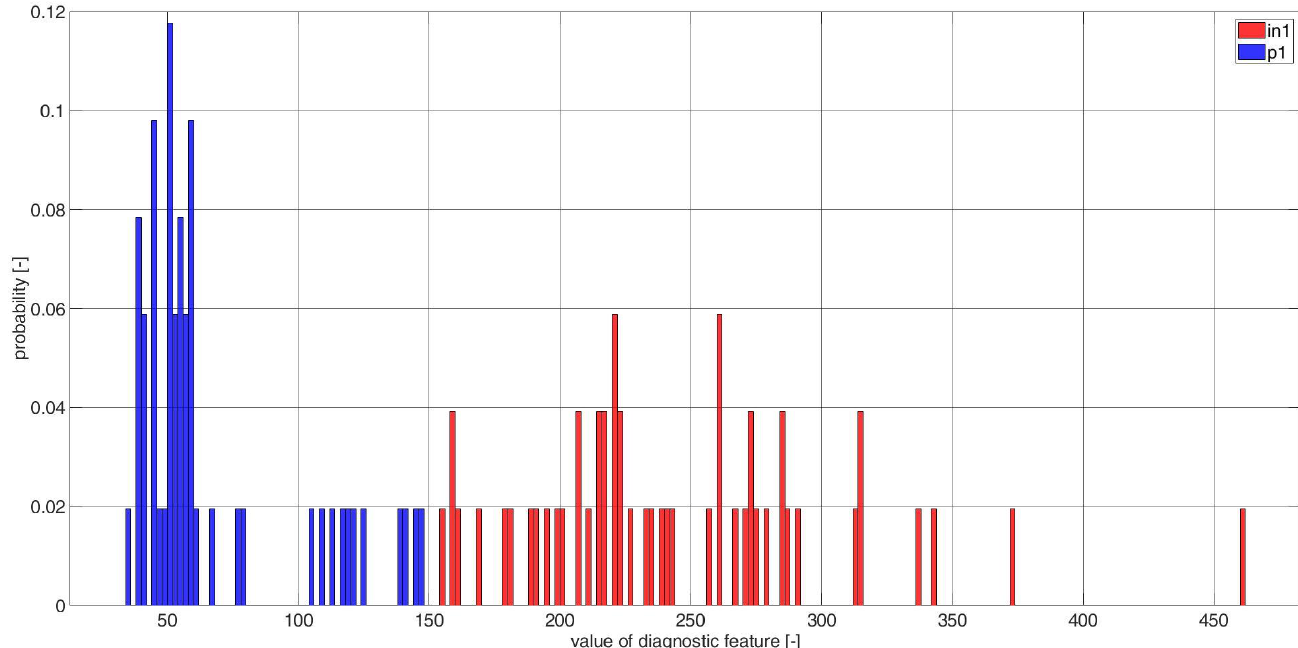
Figure A16. Histograms of diagnostic features based on the CCSM3 (correlation number is 13 — Table A1) bearings in2 and p2.